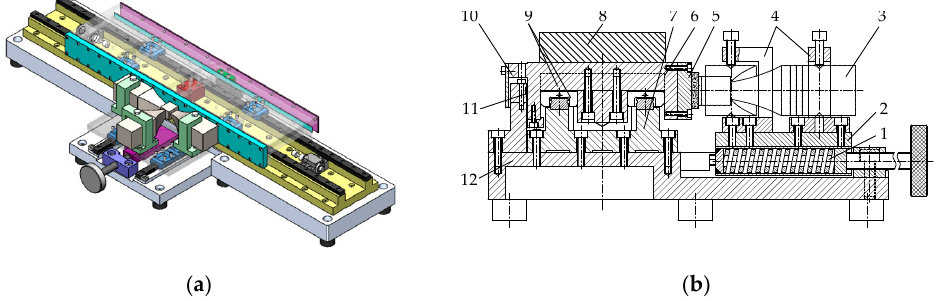
Figure 8. Experimental platform structure diagram: ( a ) The 3D model of general linear ultrasonic motor experimental platform; ( b ) The side-view of general experimental platform. 1. thrust spring; 2. stator mounting plate; 3. Motor; 4. motor mounting bracket; 5. friction material installation plate; 6. load sliding table; 7. guide rail installation pedestal; 8. inertia load block; 9. guide rail sliding block; 10. reading head; 11. grating scale; 12. experimental platform pedestal.